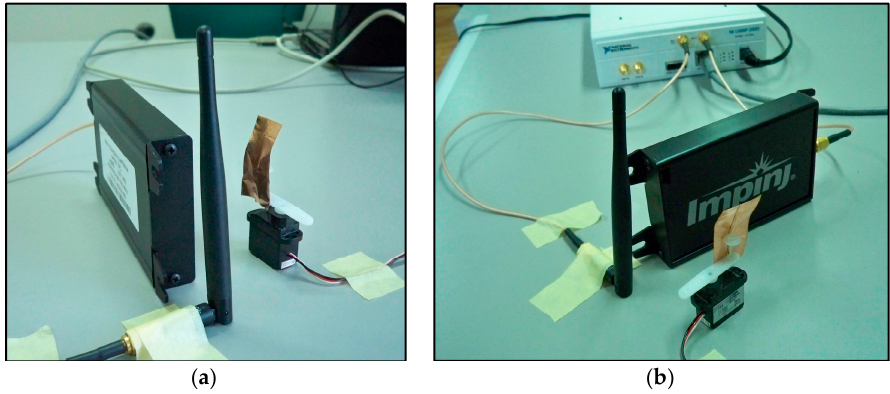
Figure 15. Setup of the second experimental test: ( a ) stepper micro motor with target in the presence of Tx and Rx antennas; ( b ) full SDRadar Doppler configuration on the second scenario.